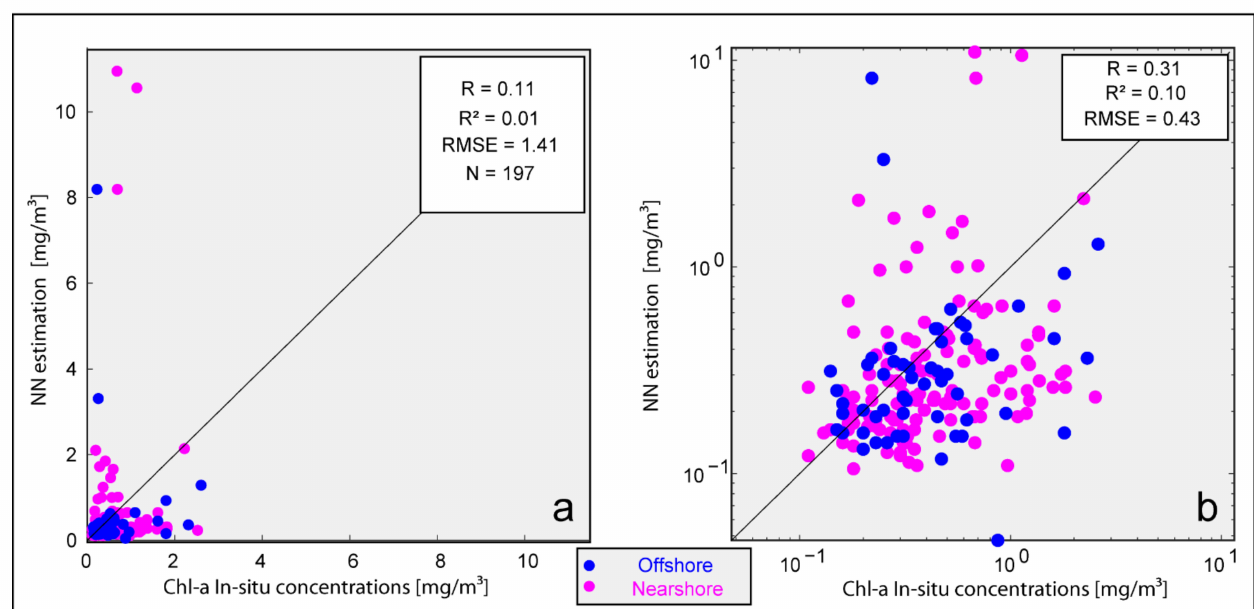
Figure 5. ( a ) Scatter plot of in-situ Chl- a concentration versus NN Chl- a estimates. ( b ) Same in logarithmic scale. The offshore and nearshore stations (Figure 1) are plotted in blue and magenta colors,